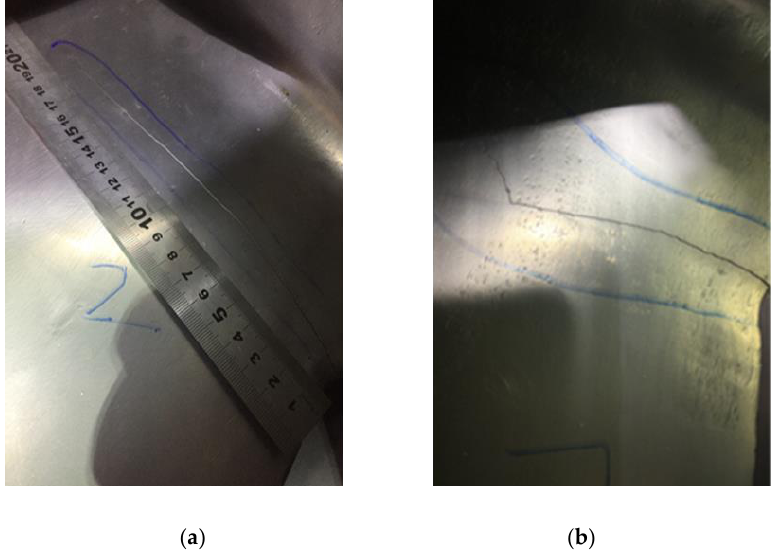
Figure 1. Cracks on the runner blades. ( a ) The crack on the first blade; ( b ) The crack on the second blade.